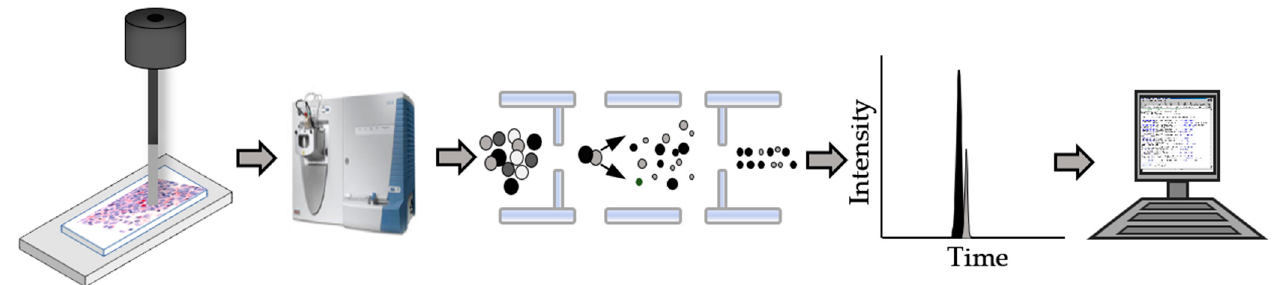
Figure 3. Quantitation of biomarkers extracted from formalin-fixed paraffin-embedded (FFPE) tissue using Liquid Tissue-selected reaction monitoring mass spectrometry (SRM-MS). Specific areas are removed from the FFPE tissue using laser capture microdissection. These sections are placed in a tube to be deparaffinized and the proteins extracted and digested into peptides. At this stage a known amount of stable isotope labeled internal standard is added to enable the absolute quantitation of specific biomarkers to be measured using SRM-MS. The patient-specific data is then analyzed to diagnose the tumor or determine the best course of treatment.